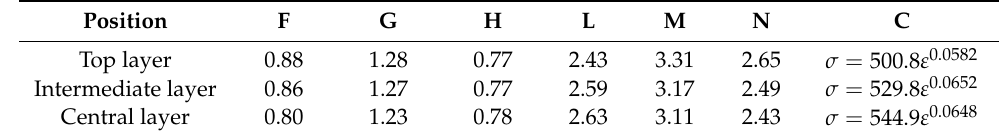
Table 2. Coefficients of Hill’s anisotropic yield criterion in three different layers for AA 7075 thick plate.